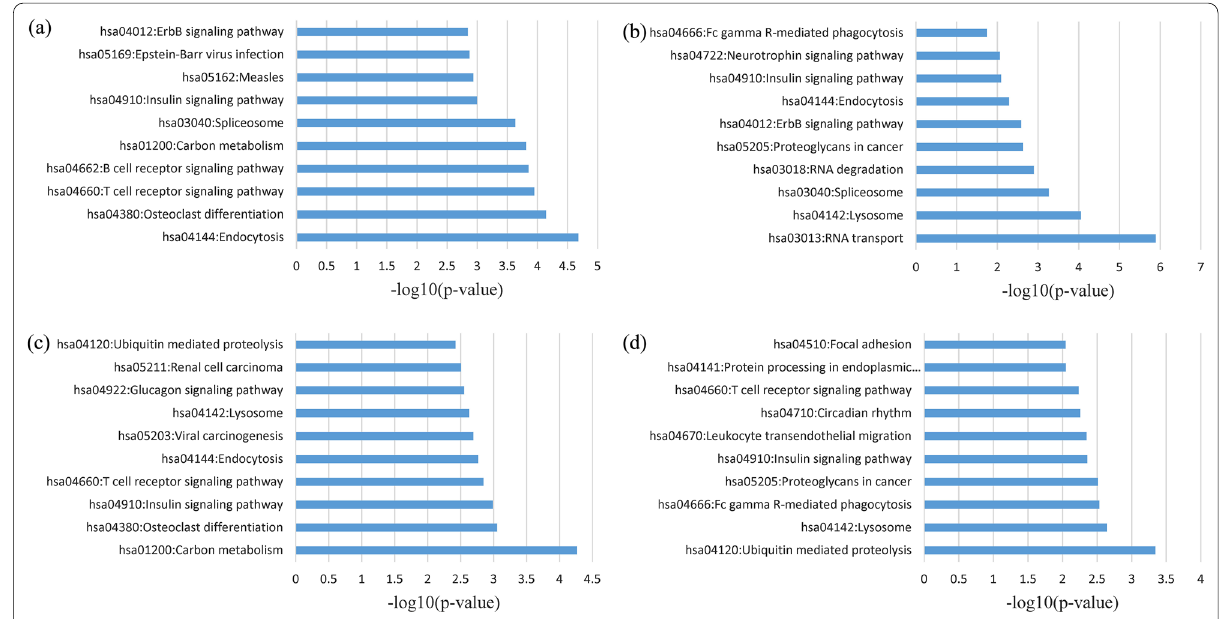
Fig. 4 KEGG signaling pathways enrichment analysis of overlapping DEGs: a mild COVID-19 versus CHB, b mild COVID-19 versus HCC, c severe COVID-19 versus CHB, d severe COVID-19 versus HCC